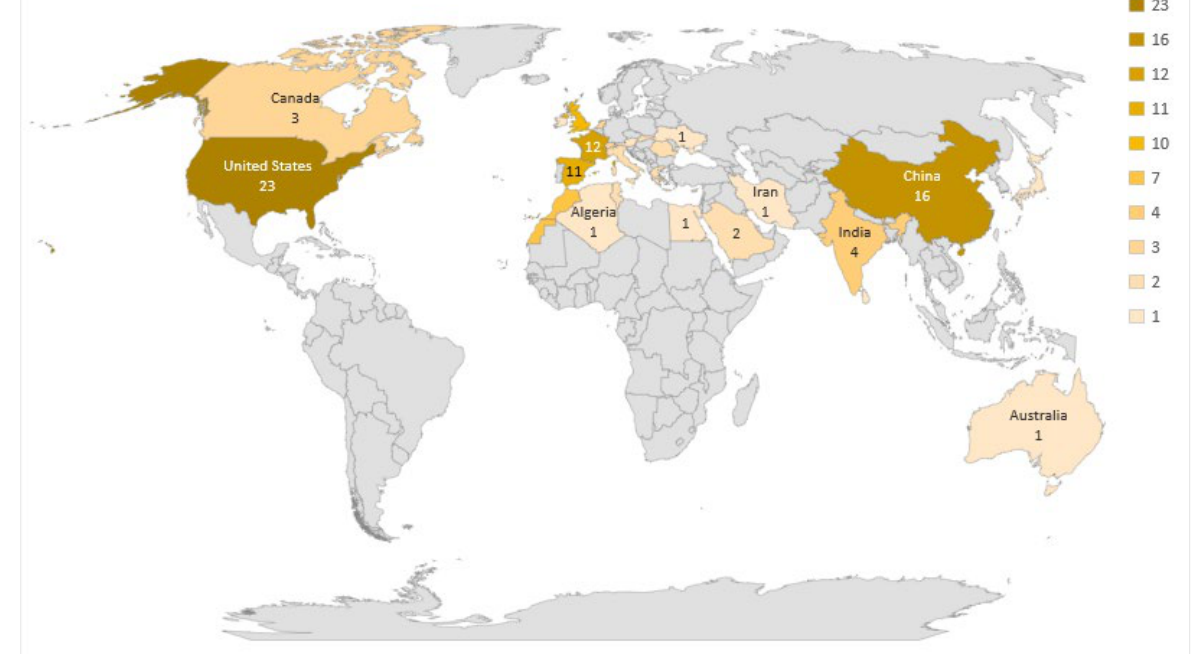
Figure 3. Distribution of work with respect to country/region of first